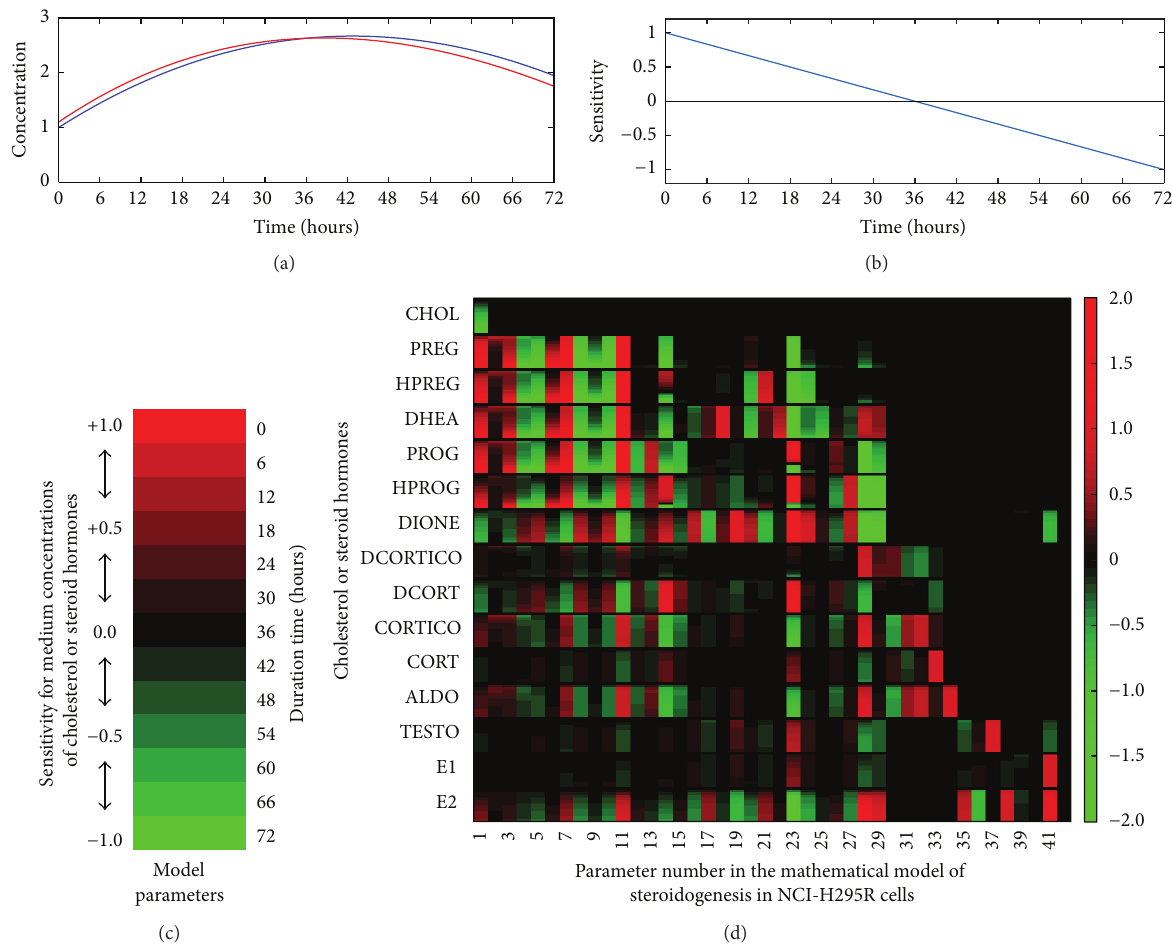
Figure 6: Heat-map of the global dynamic sensitivity analysis of adrenal steroid concentrations produced by NCI-H295R cells. The global dynamic sensitivity analysis is a powerful tool to comprehensively understand the dependencies of the model parameters in the mathematical model of the biological complex system. Dynamic sensitivities of model parameters in the mathematical model of adrenal steroidogenesis in NCI-H295R cells were calculated for all steroid concentrations in the culture medium every 6 h until 72 h after stimulation. To clarify the view of heat-map of global dynamic sensitivity analysis, imaginary data of the dynamics of steroid concentrations in the original model (blue line) and perturbed model for sensitivity analysis (red line) were prepared (a). Using this imaginary data, the calculated dynamic sensitivities (b) and the visualized dynamic sensitivity as one block of the heat-map (c) were shown, respectively. By the same method that explained using imaginary data, the large-scale data of the global dynamic sensitivity analysis on the mathematical model of adrenal steroidogenesis in NCI-H295R cells was comprehensively visualized as a big graph of heat-map (d). Parameter numbers in the horizontal axis are (1) 𝑘 MTR 𝑘 acc 𝑘 acc 𝑘 loc 𝑘 loc 𝑘 𝐾 CYP 11 A 1 𝑘 Choresterol Transport , (2) 𝑘 CEH , (3) 𝑘 MTR Oxysterol Synthesis , (10) 𝑓 , (4) 𝑏 , (5) 𝑓 , (6) 𝑏 , (7) 𝑓 , (8) 𝑏 , (9) 𝑚